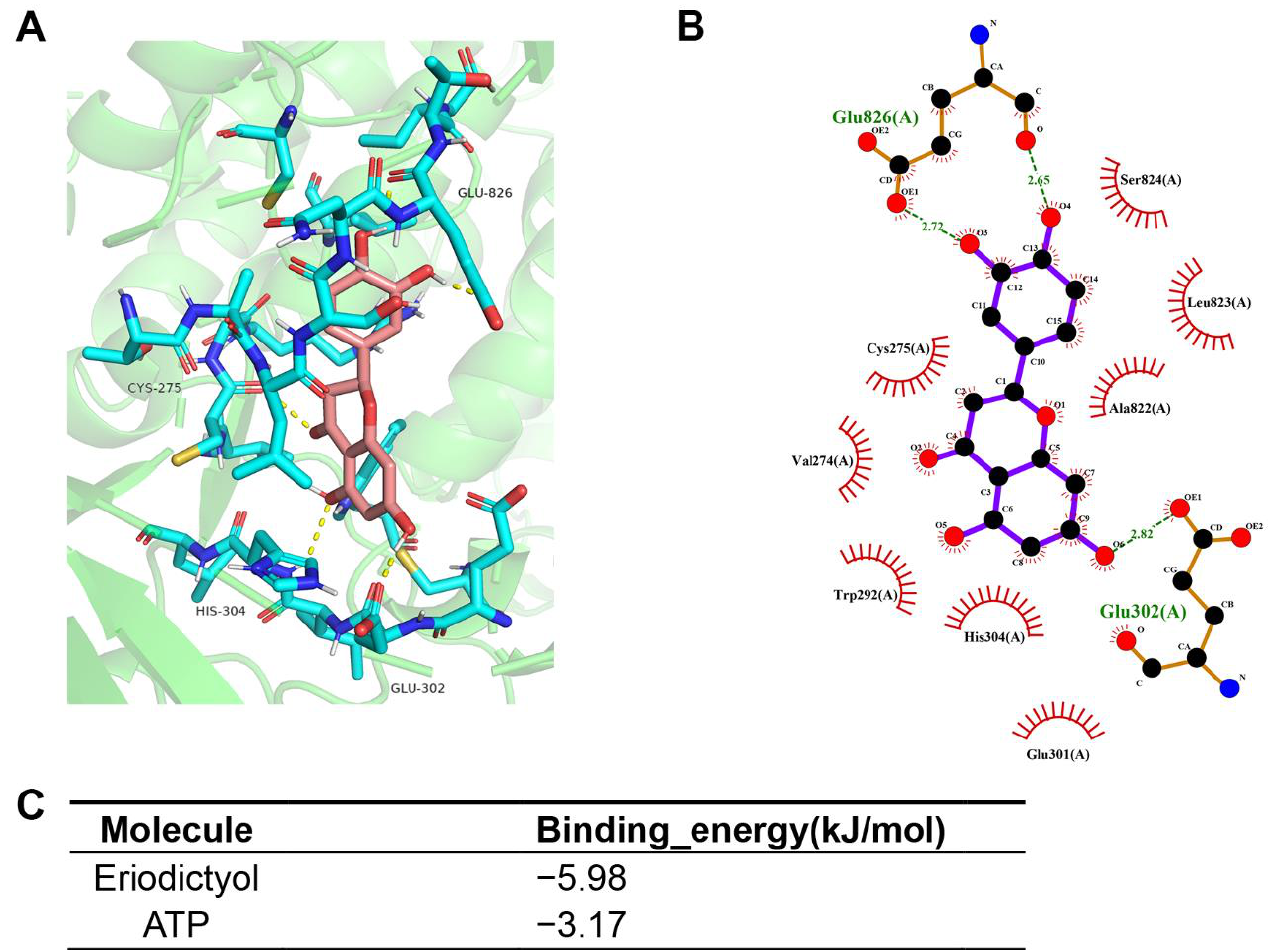
Figure 6. Molecular docking models of eriodictyol and PIK3CG. ( A,B ) Schematic diagram of docking results of 3D ( A ) and 2D ( B ) interactions between eriodictyol and PIK3CG. ( C ) Affinity analysis of eriodictyol and ATP bonding to PIK3CG.